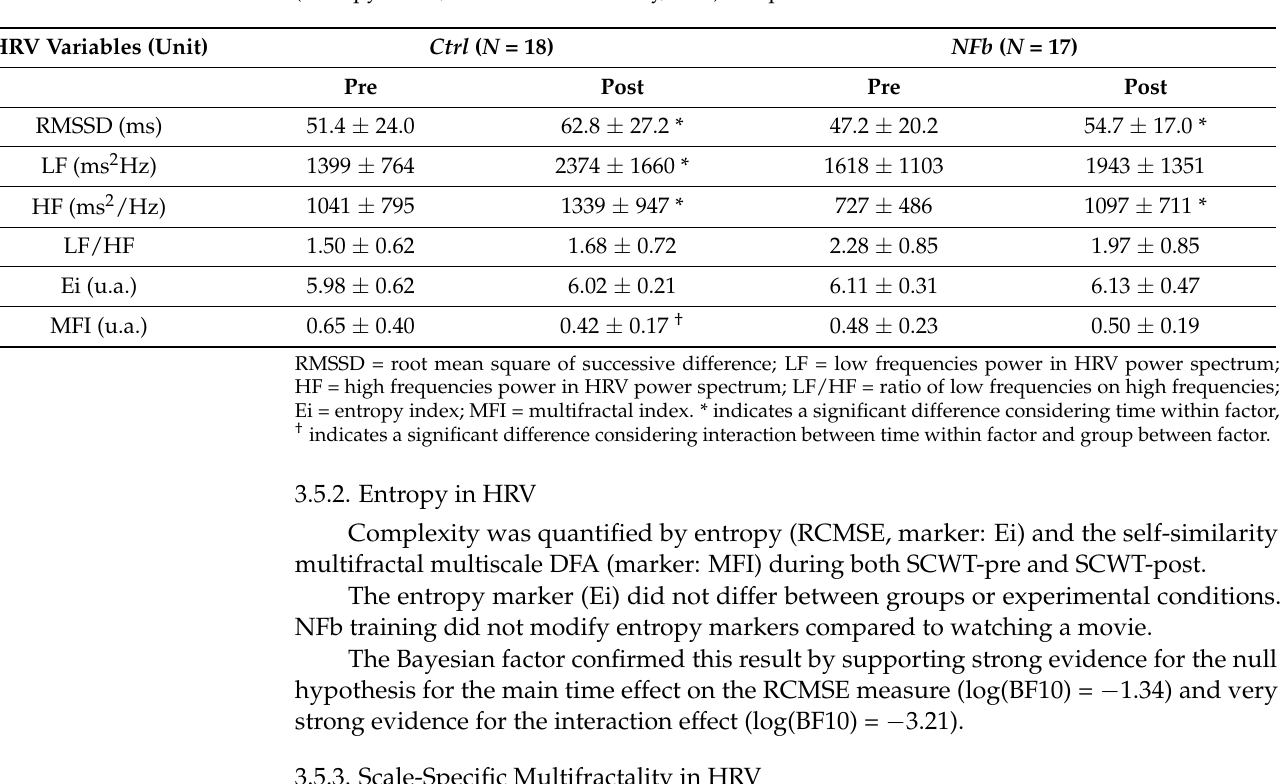
Table 3. Mean ( ± standard deviation) of time-(RMSSD) and frequency (Low Frequencies: LF, High Frequencies: HF, sympatho-vagal ratio: LF/HF) domains indices and nonlinear complexity indices (entropy index, Ei and multifractality, MFI) computed from RR time